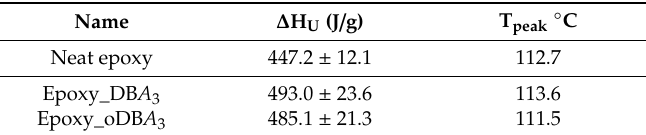
Table 4. Results of di ff erential scanning calorimetry (DSC) scans at 10 ◦ C / min, for the neat epoxy resin and epoxy resin with 3 wt.% DBA and oDBA: enthalpy changes, normalized with respect to the resin weight ( ∆ H U ) and peak temperature ( T peak ).